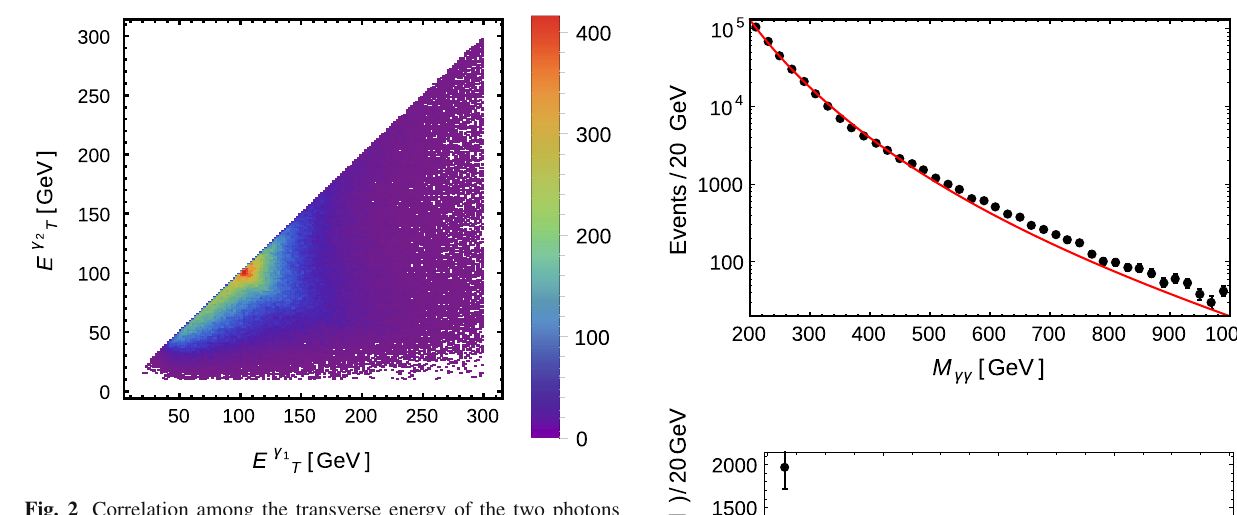
Fig. 2 Correlation among the transverse energy of the two photons coming from the gluon fusion process. The photon density per 10 × 10 GeV 2 bin is given by the color bar